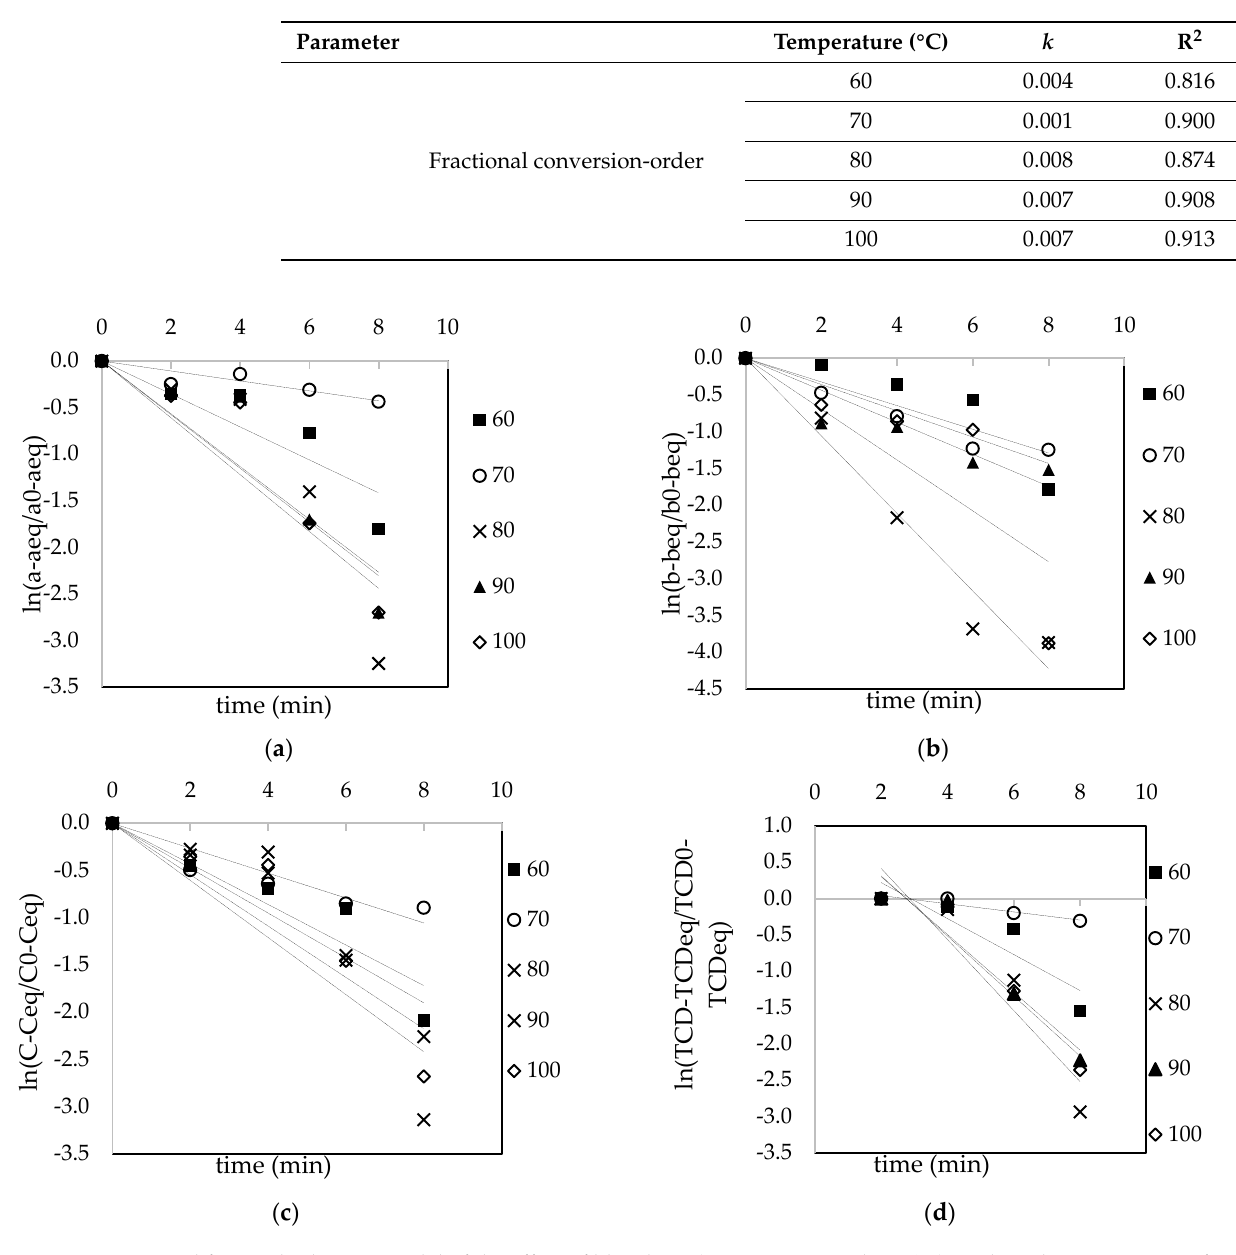
Figure 4. Fractional first-order kinetic model of the effect of blanching (60, 70, 80, 90 and 100 ° C) on the color parameters of Dabai fruit: ( a ) a *, ( b ) b *, ( c ) chroma and ( d ) TDC . Table 1. The reaction rate (k) and coefficient of determination (R 2 ) of the zero-order kinetic model, first-order kinetic model and fractional conversion order kinetic model of changes of color parame- ter ( a *, b *, C and TCD ) of Dabai fruit, due to blanching.